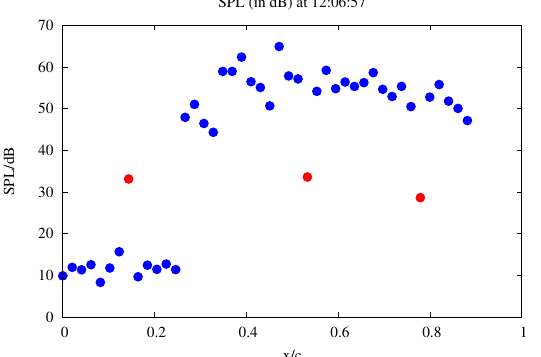
Figure 21. Development of SPL vs. chord at 12:06:57. If one discards outliers (in red), x tr, M / c may be deduced to x tr, M / c = 0.34 ±